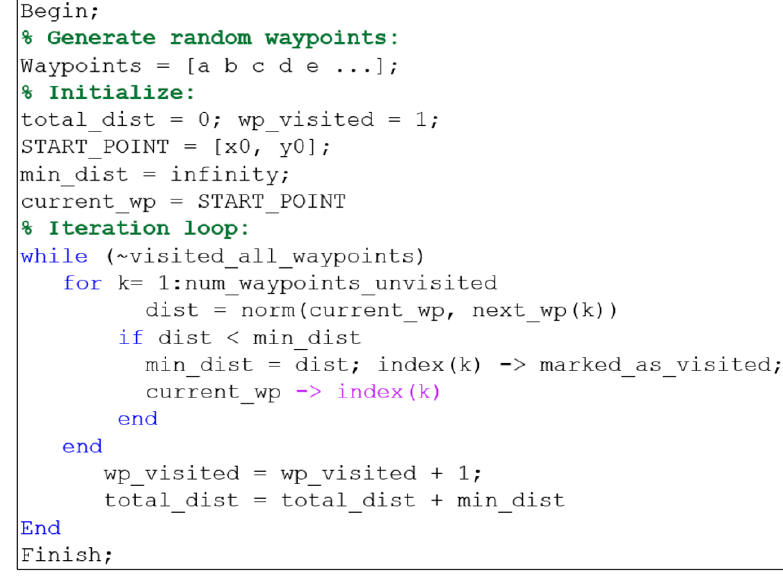
Figure 6. The Genetic Algorithm pseudo code. Figure 7. The proposed bumblebee flight survey was executed on arrival at a waypoint ( a , b ). A full AUV trajectory is shown where no oil plume is detected ( c ). The green dotted line indicates the planned AUV trajectory. The red line corresponds to the actual AUV trajectory on performing the bumblebee flight.